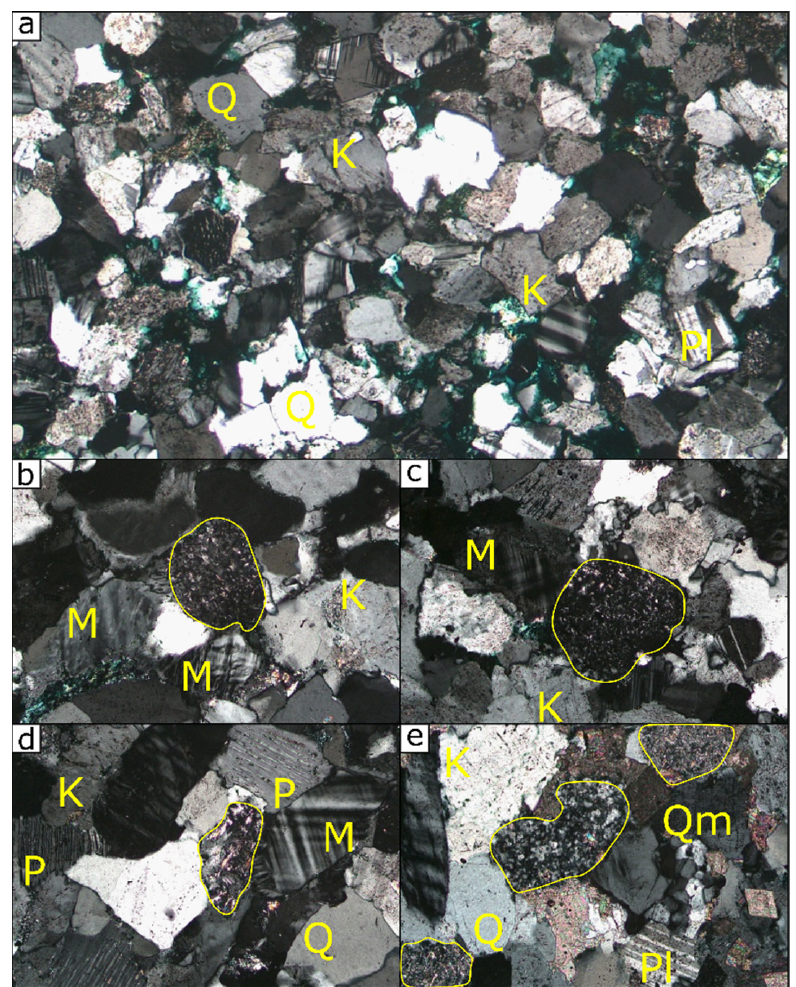
Figure 6. ( a ) Typical K-feldspar rich nature of the Bunatrahir West sequence, where Q: quartz; K: K-feldspar; Pl: plagioclase; M: microcline; P: perthite; Qm: microcrystalline quartz. Field of view c. 2 mm; ( b – e ). Detrital igneous grains of varying appearance. Field of view c. 0.4 mm. Orthoclase is the most common feldspar in all MSFm samples, followed by microcline. Plagioclase and perthite are also typically present in equal amounts, except in sample 1 (noted above) and sample 3, where plagioclase is slightly more abundant than